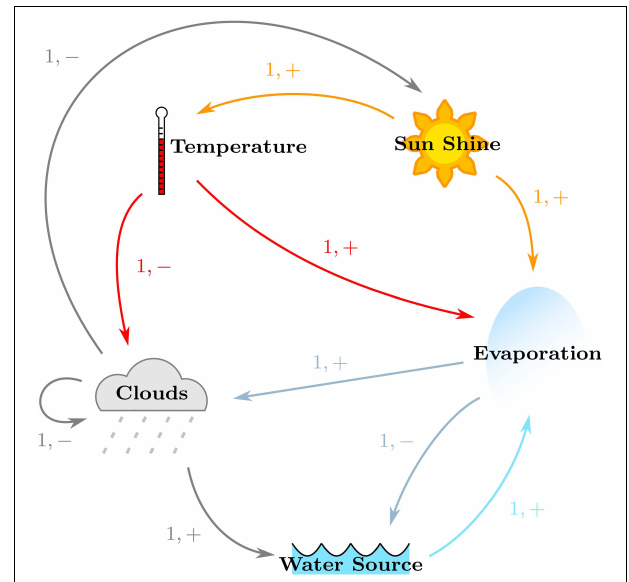
FIGURE 7 | Regulatory network of Case Study 2: Atmospheric